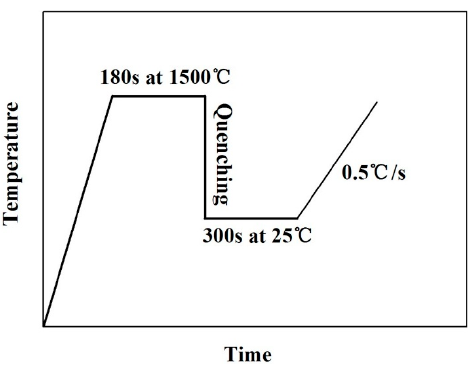
Figure 7. Temperature controlling profile for the glassy/crystalline phase transition temperature measurements.